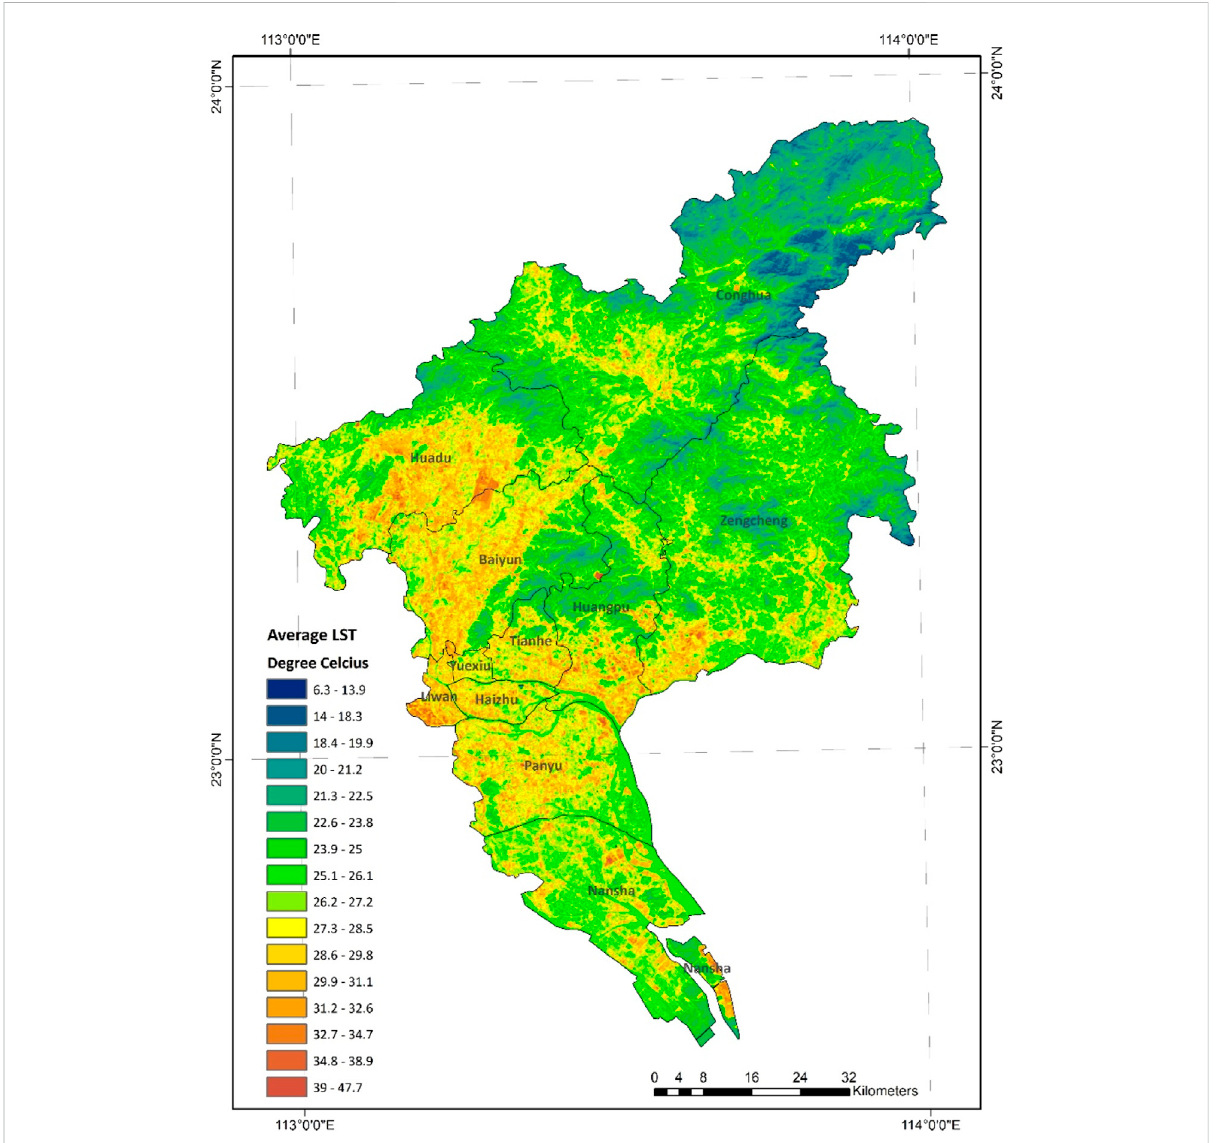
FIGURE 4 TheaverageLSTdistributioninGuangzhoubetweenselecteddaysinOctoberandNovember,whichrepresentstheautumnseasonthatismost impacted by UHI in